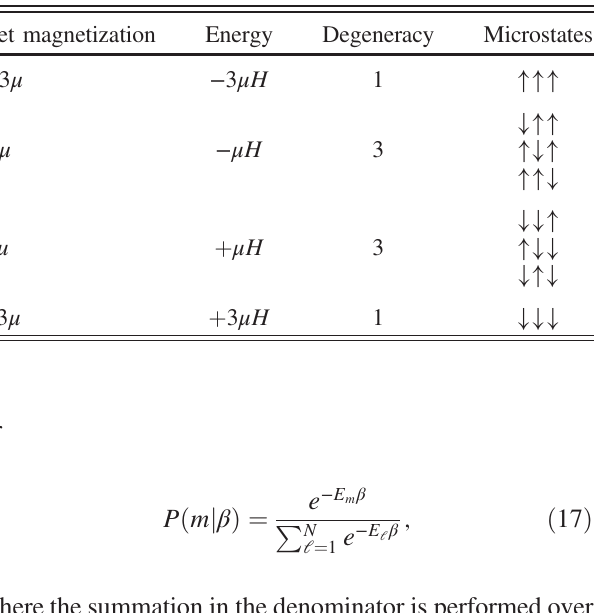
TABLE II. Macrostates for a paramagnet with three distin- guishable spin- 1 = 2 particles in a magnetic field of strength H . Each spin has a magnetic moment with magnitude μ . For the microstates, ↑ indicates that the spin is aligned with the field H (spin up), and ↓ indicates that the spin is antialigned (spin